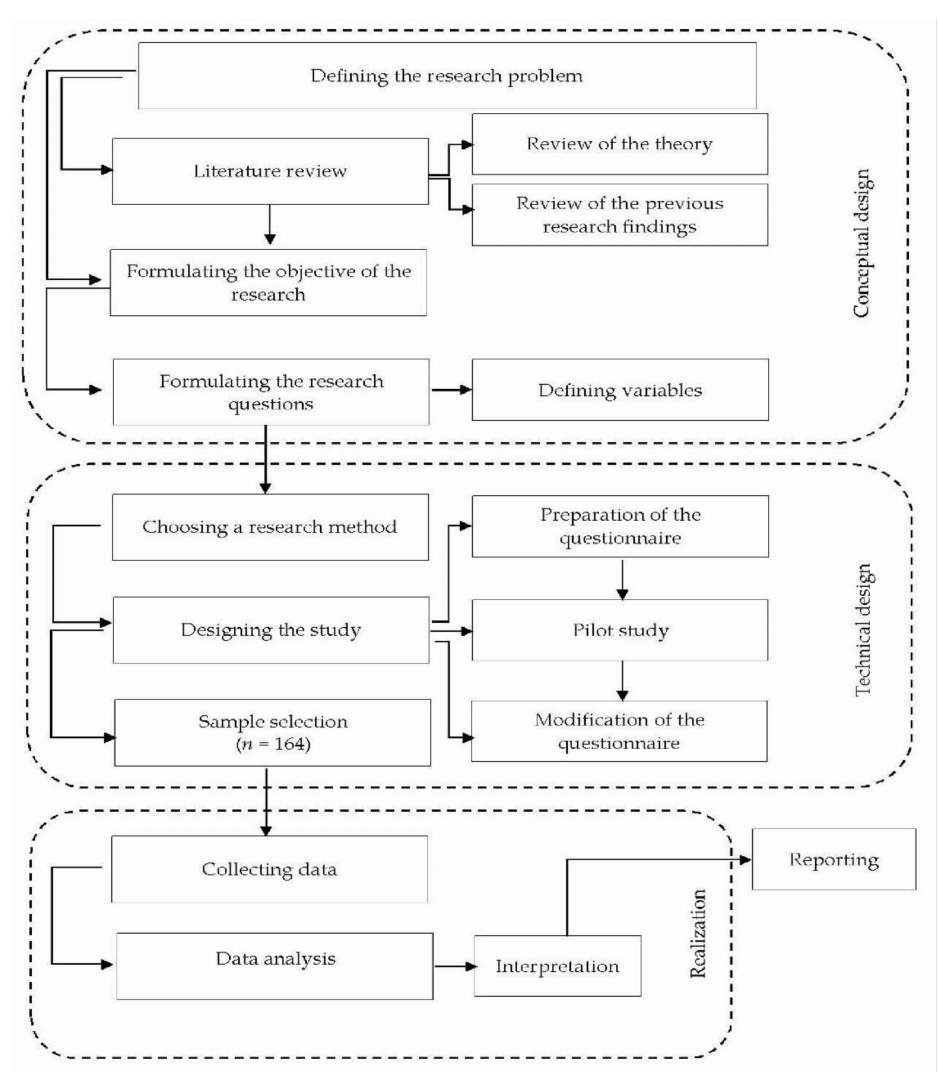
Figure 2. Research methods and